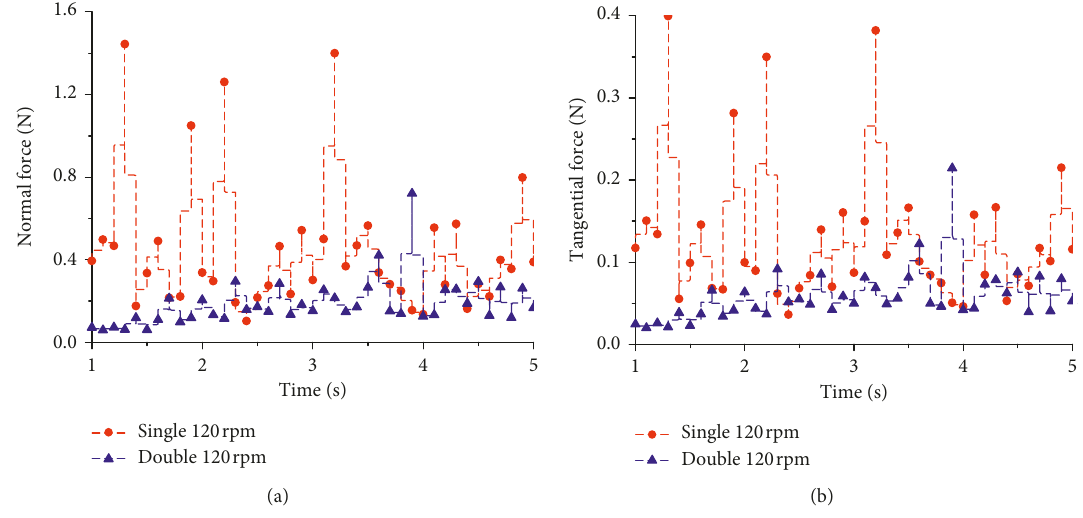
Figure 5: The contact force between particles in the single/double-flight screw feeders.